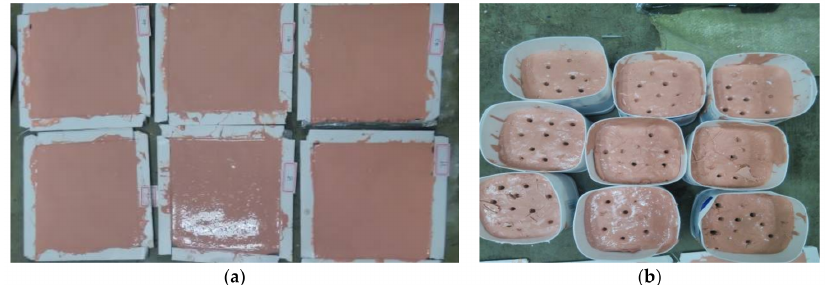
Figure 2. Test for setting behavior of the geopolymer coating. ( a ) Setting time; ( b ) Penetration resistance.